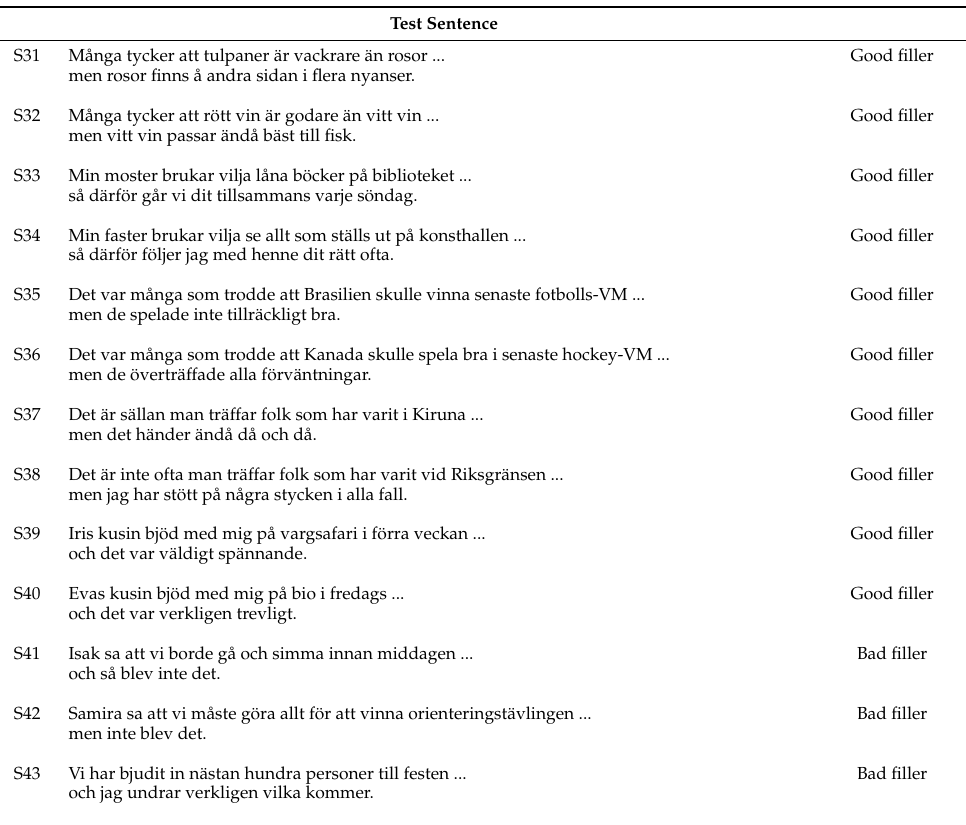
Table A2. Swedish filler sentences.